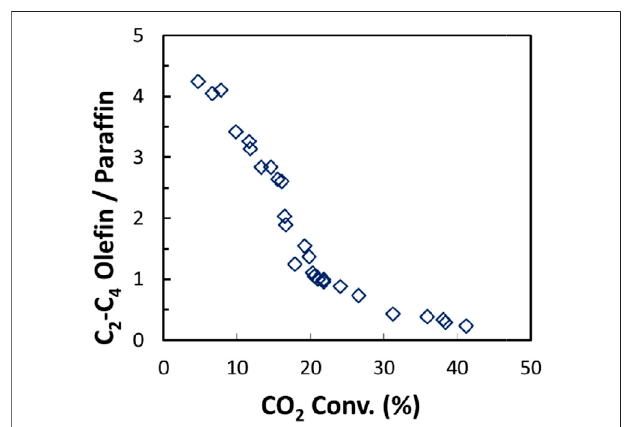
FIGURE 14 | C 2 -C 4 ole fi n/paraf fi n ratio as a function of CO 2 conversion from CO 2 hydrogenation over the Fe-Cu(0.17)/K (0.3)/Al 2 O 3 catalyst at 573 K and 1.1 MPa.